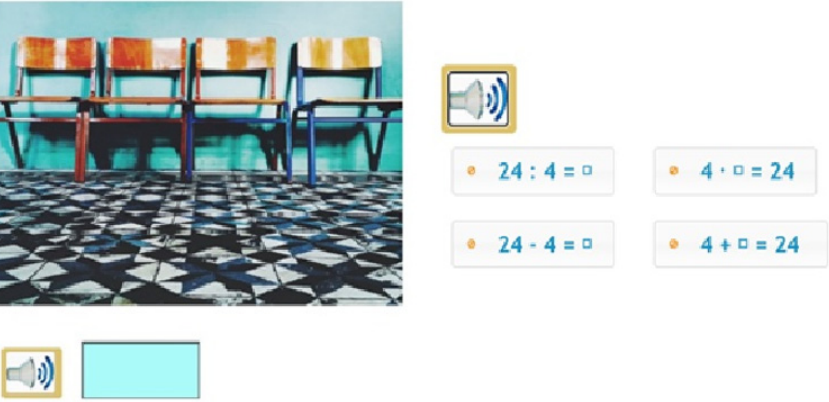
Figure 2. Example of a task (Transcripts: Step 1: This is how many chairs are placed next to each